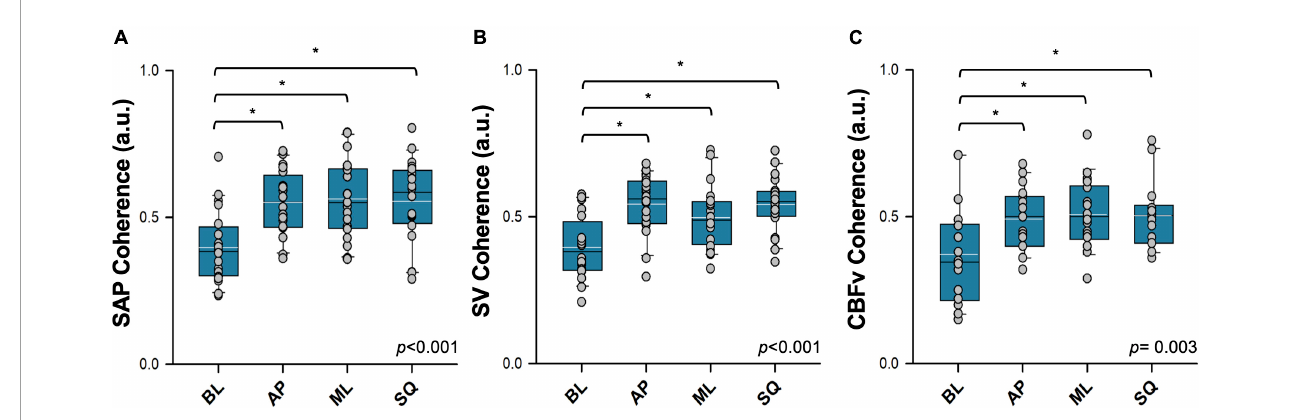
FIGURE7 Coherence between postural sway and cardiovascular responses assessed using cross-spectral analysis. Coherence between postural sway and (A) systolic arterial pressure (SAP), (B) stroke volume (SV), (C) cerebral blood flow (CBFv) are shown. Absolute values of mean coherence in each condition are reported. Signals were recorded during quiet standing (BL; baseline sway), and in three exaggerated sway patterns (AP: anterior-posterior sway; ML: mediolateral sway; SQ: square sway). Main effects are indicated in the bottom right corner of each plot. *Significantly different from baseline ( p < 0.05). Black = sample mean, white = sample median.